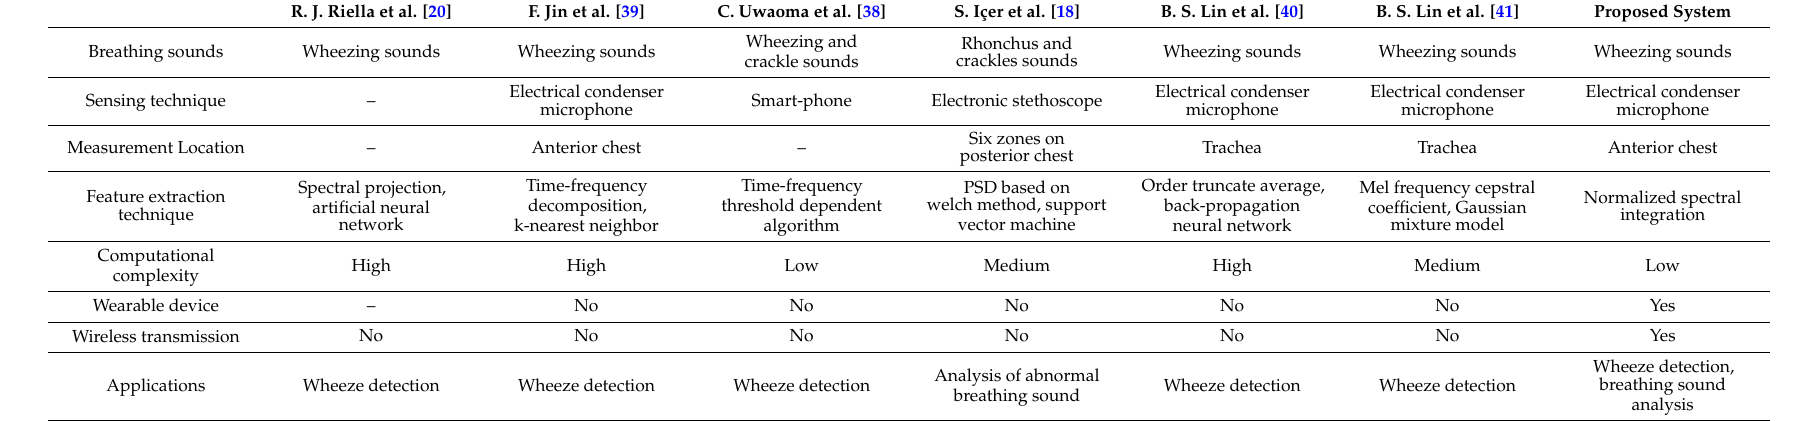
Table 3. System comparison between proposed system and other